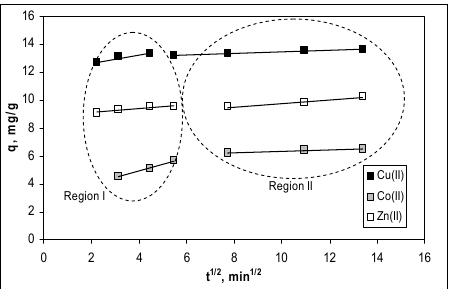
Figure 5. Linear representations of the intra-particle diffusion model for the biosorption of Cu(II), Co(II) and Zn(II) ions on alginate.